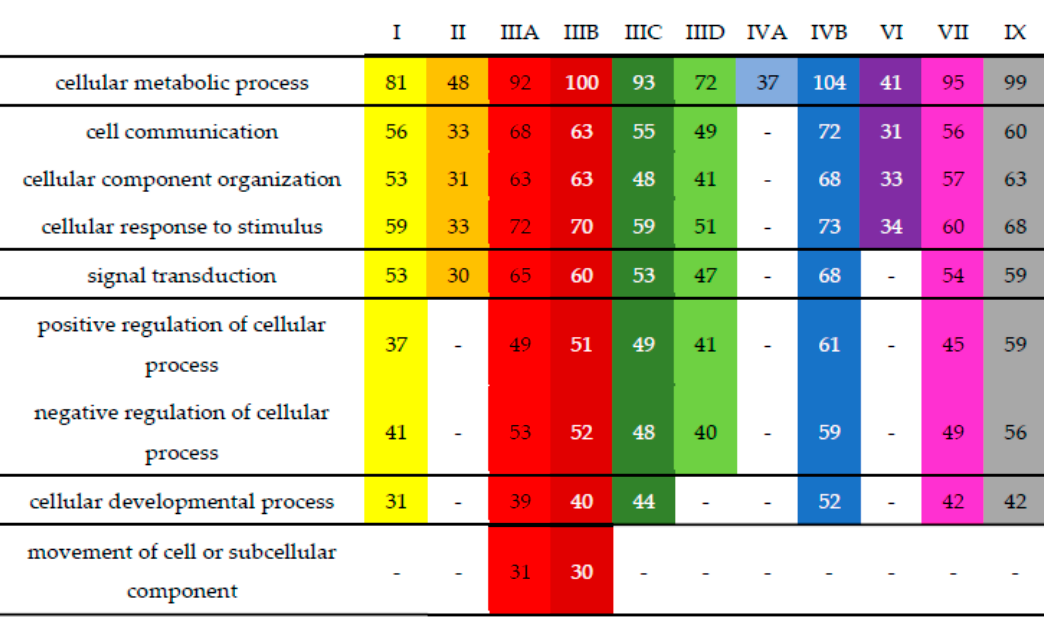
Figure 3. Cellular processes in which at least 30 kinds of transcripts were particularly strongly changed (FDR < 10 − 6 , p < 0.1) in different MPS types. The “rainbow” diagram ( A ) shows these processes in order to demonstrate which process in significantly affected in which MPS types. The colors correspond to MPS types shown in panel ( B ), in which the number of severely changed transcripts of genes which products are involved in particular processes are indicated.